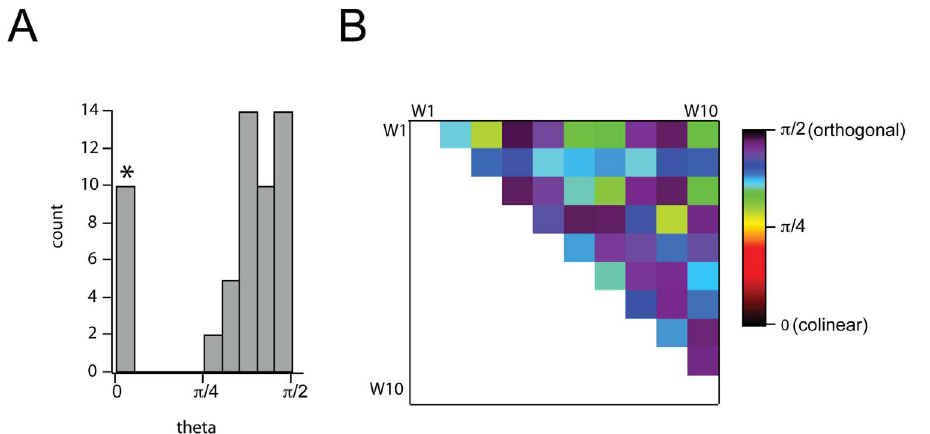
Figure 5. Approximate orthogonality of the NMF basis vectors. A ð Þ Histogram of angles subtended by all pairs of basis vectors, W . Histogram was constructed for all pairwise comparisons between dimensions, excluding self-comparisons. Bar with (*) denotes self-comparisons. B ð Þ Matrix of pairwise comparisons of angles between dimensions.